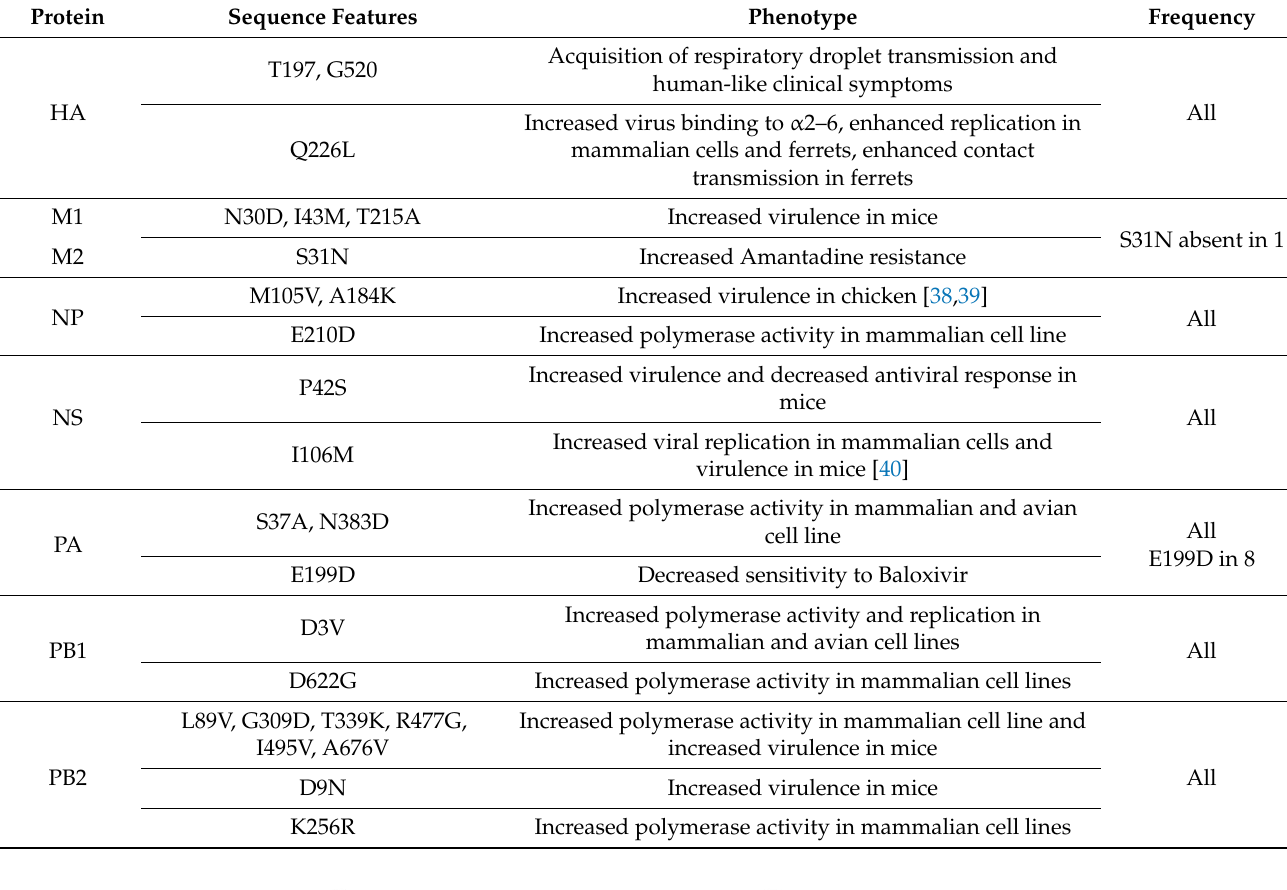
Table 1. Sequence Feature Variants in H9N2 virus proteins and their phenotypic function.